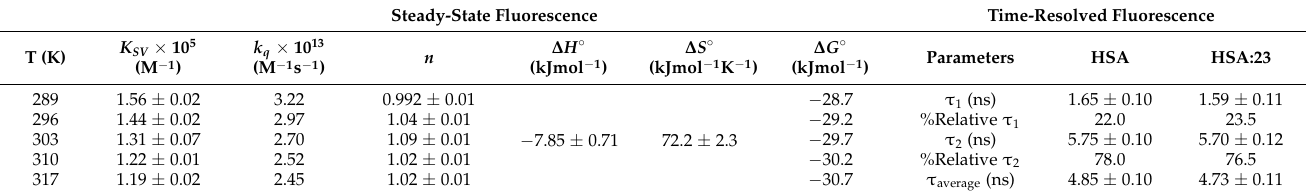
Figure 7. ( A ) Steady-state fluorescence emission spectra ( λ exc = 280 nm) for HSA without and upon successive additions of 23 at pH = 7.4 and 310 K. ( B ) Stern-Volmer plots for the HSA:23 interaction in PBS. ( C ) Time-resolved fluorescence decays for HSA (1.0 × 10 − 5 M) without and with 23 (1.32 × 10 − 5 M) at pH = 7.4 and 296 K. The residuals were obtained by biexponential treatment with χ 2 values of 1.027 and 1.142 for HSA and HSA:23, respectively. ( D ) Double-logarithmic plots for HSA:23 in PBS. ( E ) Stern-Volmer plots for HSA:23 without and with the site markers warfarin, ibuprofen, or digitoxin at 310 K. ( F ) Van’t Hoff plot based on K SV values for HSA:23. ( G ) Secondary structure content of HSA (1.0 × 10 − 6 M) without and with 23 (proportion 1:10). SF spectra of HSA without and upon successive additions of 23 at ( H ) ∆ λ = 15 nm for Tyr residues and ( I ) ∆ λ = 60 nm for Trp residues in PBS at room temperature. Concentrations: HSA = 1.0 × 10 − 5 M; 23 = 0.17, 0.33, 0.50, 0.66, 0.83, 0.99, 1.15, and 1.32 × 10 − 5 M. Table 8. Binding constant values for the interaction between HSA and compound 23 in PBS